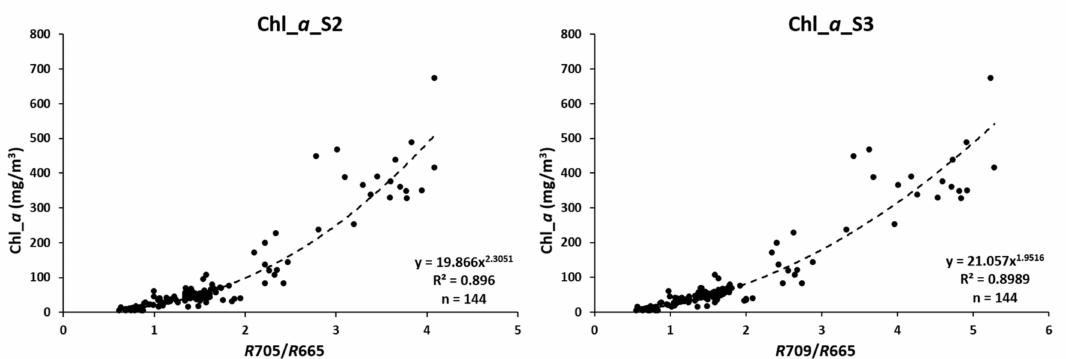
Figure 9. Chl_a algorithms recalculated using all data upper 5 mg/m 3 .